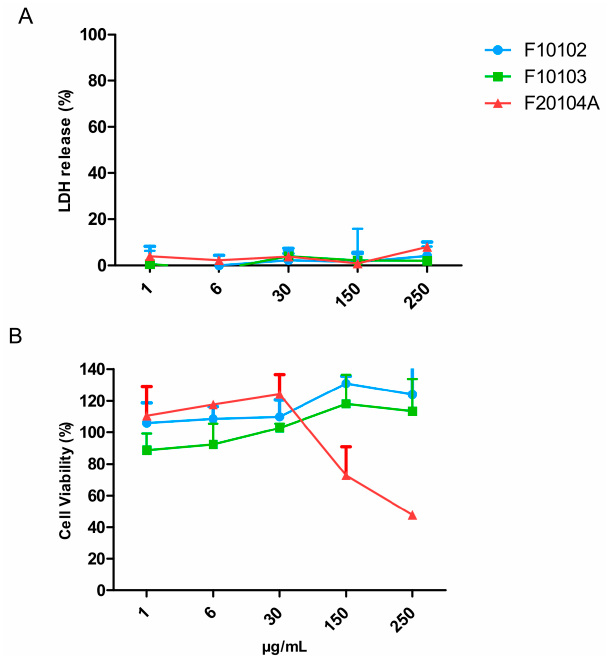
Figure 6 Figure 6. Cell death (% LDH release; A ) and cell viability (% MTT metabolic transformation; B ) of PBMC exposed to liposomes F10102, F10103, and F20104A for 24 h. The error bars represent the SD of three independent experiments. Negative controls (cells incubated with medium) and positive controls (cell lysed with Triton) were used as